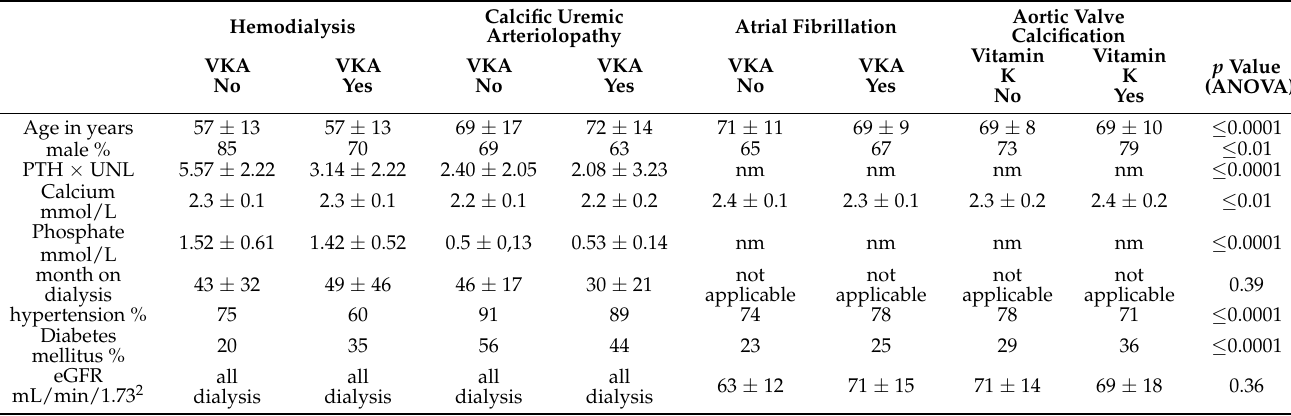
Table 1. Clinical